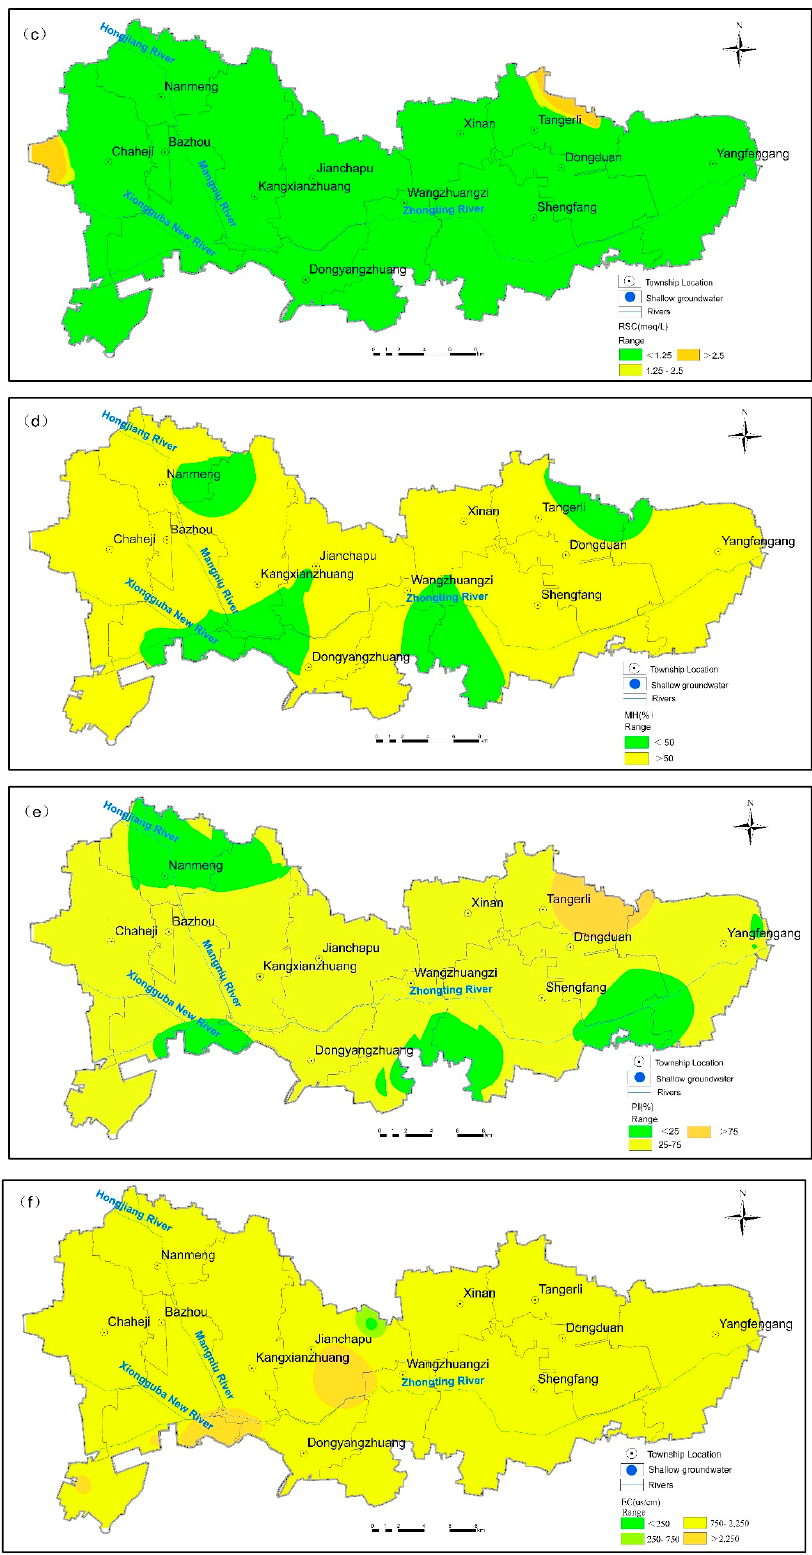
Figure 6. Classification of groundwater suitability for irrigation based on different indexes of ( a ) sodium adsorption ratio (SAR), ( b ) sodium percentage (%Na), ( c ) residual sodium carbonate (RSC), ( d ) magnesium hazard (MH), ( e ) permotic index (PI), and ( f ) electrical conductivity (EC).